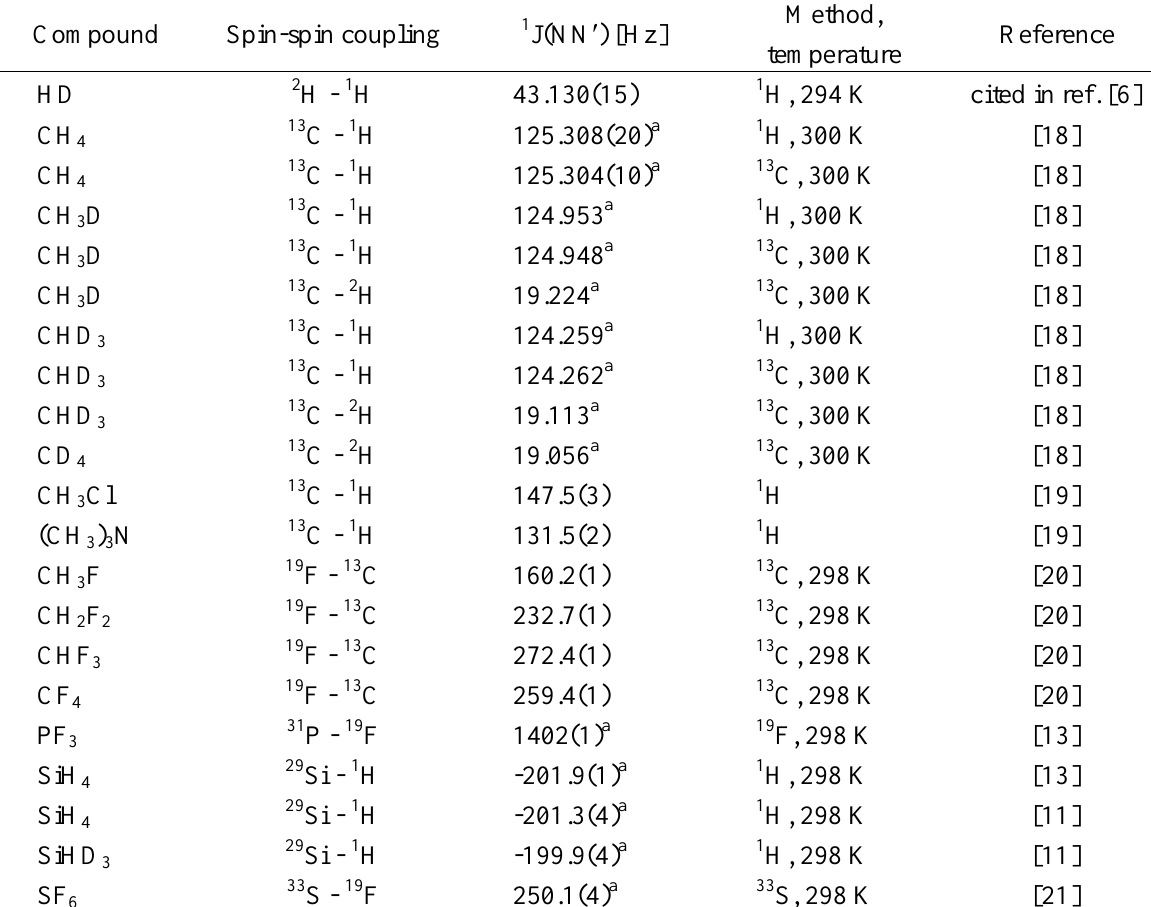
Table 3. Representative one-bond spin-spin coupling constants measured in the gas phase.